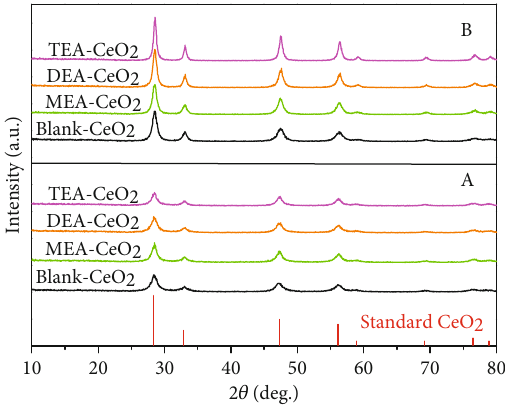
Figure 4: Relative OSC (mmol O /g) of Blank-, MEA-, DEA-, and 2 TEA-CeO powders calculated by measuring the corresponding 2 peak area of O -TPD pro fi les in Figures 2(a) – 2